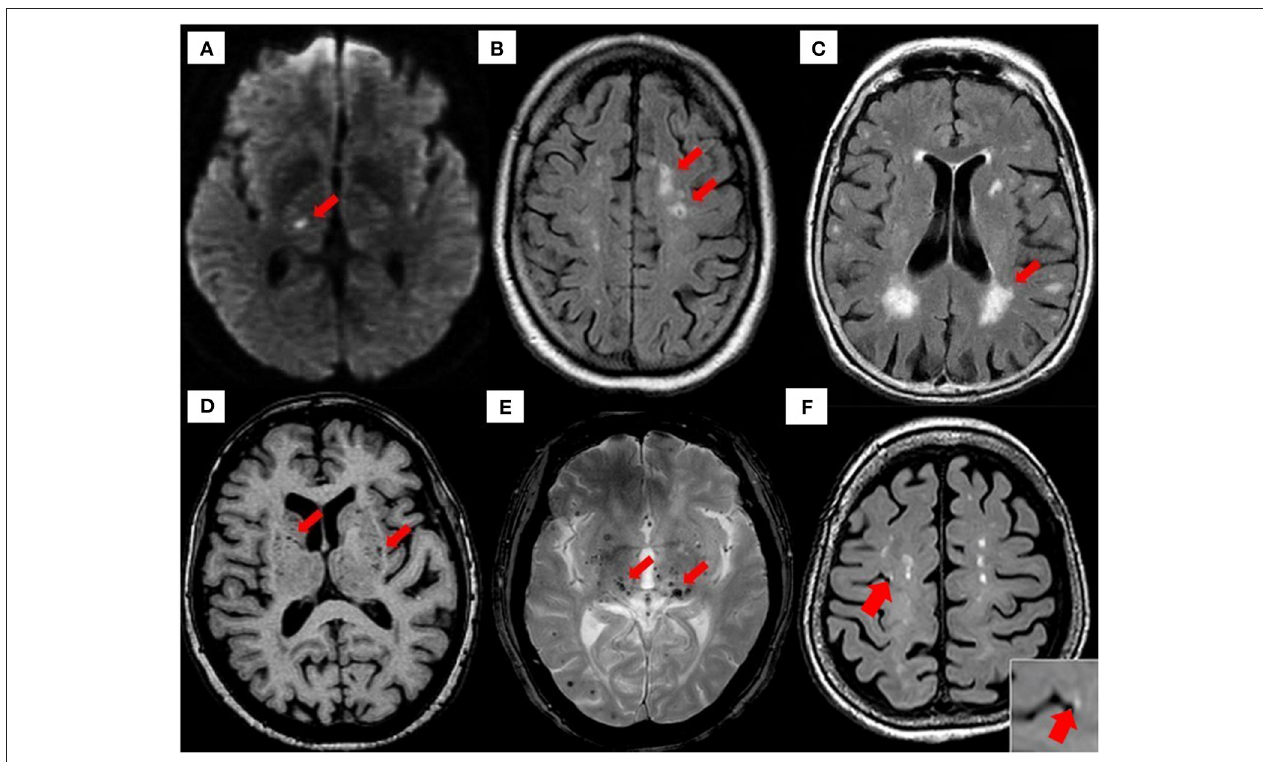
FIGURE 2 | Neuroimaging correlates of CSVD based on STRIVE method. (A) Recent small subcortical infarct (RSBI) on diffusion-weighted imaging (DWI) (red arrow). RSBI seen as increased T2-weighted, fluid-attenuated inverse recovery (FLAIR), and DWI signal intensities decreased T1-weighted signal and isointense in T2*-weighted gradient recoiled echo (GRE) signal and susceptibility-weighted imaging (SWI). RSBI is best identified through DWI with usual infarct diameter of ≤ 20mm. (B) Lacunar infracts on FLAIR (red arrow). Lacunar infarcts appeared as increased hyperintensity in T2-weighted signal, decrease T1-weighted, and FLAIR signal and isointense in DWI. Usual diameter is around 3–15mm, with hyperintense rim surrounding ovoid cavity. (C) White matter hyperintensities (WMHs) of presumed vascular origin on FLAIR (arrow). WMHS seen as increase intensity or hyperintensity on T2-weighted imaging, T2*-weighted GRE and FLAIR (best identified), isointense on DWI, and hypointense (decrease intensity) on T1-weighted imaging. (D) Enlarged perivascular spaces (PVS) on T1-weighted imaging (red arrow) with usual diameter of ≤ 2mm. PVS is seen as decrease FLAIR and T1-weighted signal intensity, with increase T2-weighted signal. Meanwhile T2*-weighted GRE and DWI appeared isointense, and they also appeared in similar signal intensity with cerebrospinal fluid (CSF). (E) Cerebral microbleeds (CMBs) on T2*-GRE (red arrow). CMBs are small, rounded areas of signal void with blooming, whereby they were visualized as isointense T1- and T2-weighted signal, FLAIR, and DWI. They are best identified under T2*-weighted GRE or SWI as reduced signal intensities. Usual diameter is around ≤ 10mm (mostly 2–5mm). (F) 3-T MRI representation of cortical microinfarcts (red arrow) on T1-weighted (hypointense) [images A–E, reproduced with permission from Mustapha et al. (57), image F is adapted from Takasugi et al.